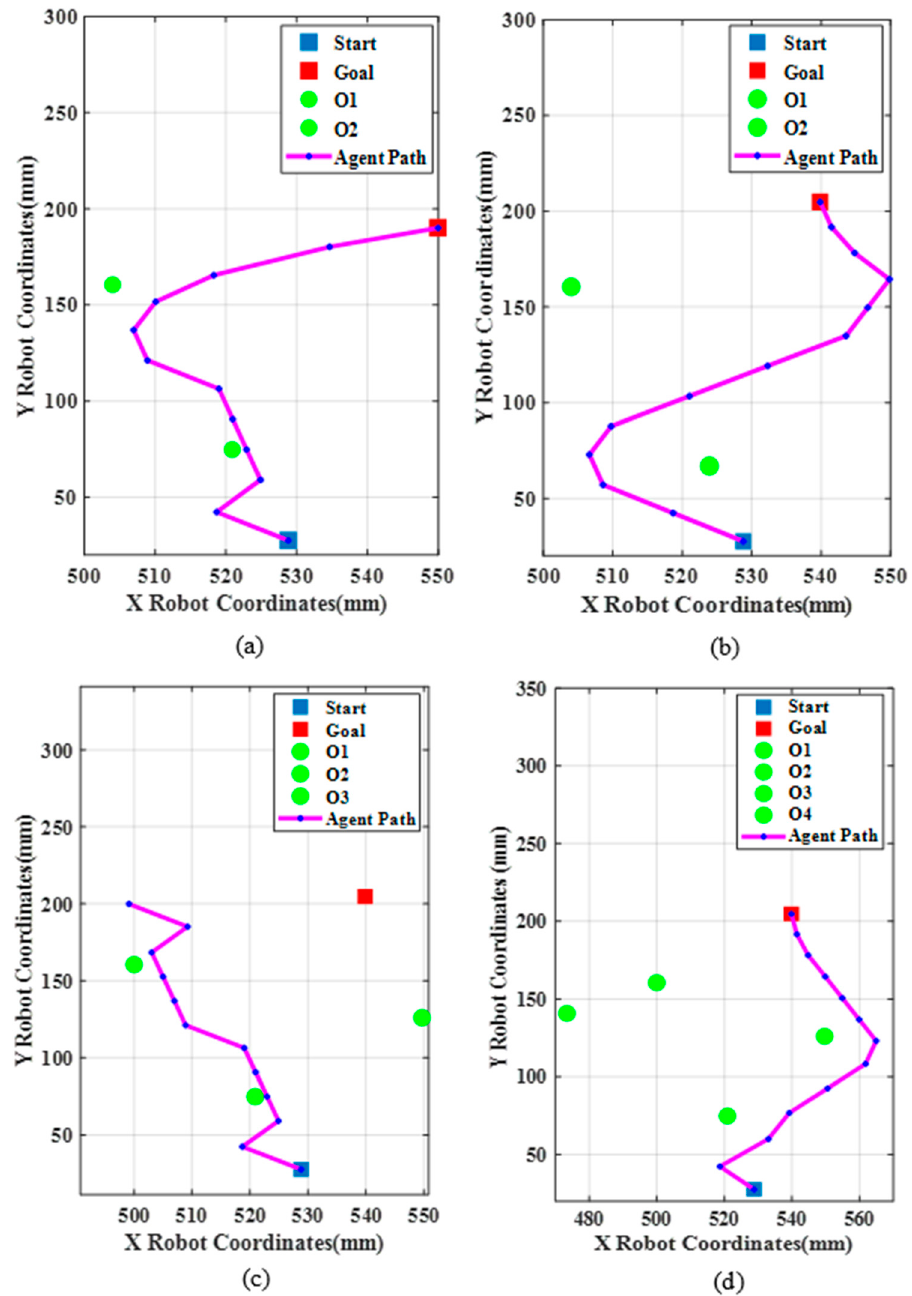
Figure 15. Path Traversed by the Robot using Double DQN ( a ) With Two Obstacles, ( b ) With Two Obstacles for Different Goal Positions, ( c ) With Three Obstacles, and ( d ) With Four Obstacles. The Yellow Colored Arrow Illustrates the Path taken by the Agent.